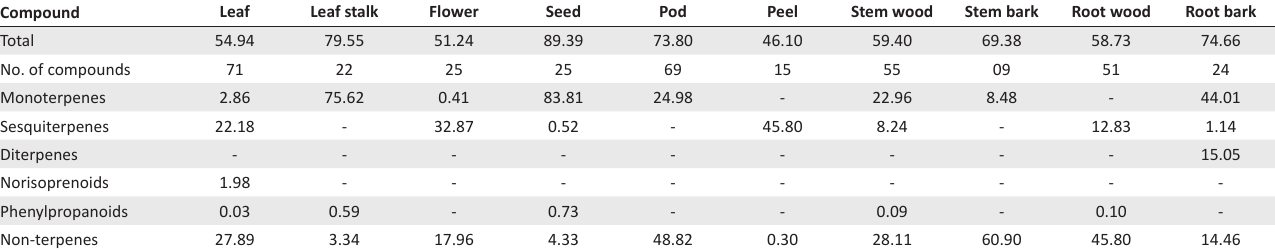
TABLE 2b: Chemical constitution of 10 essential oils from Calophyllum inophyllum